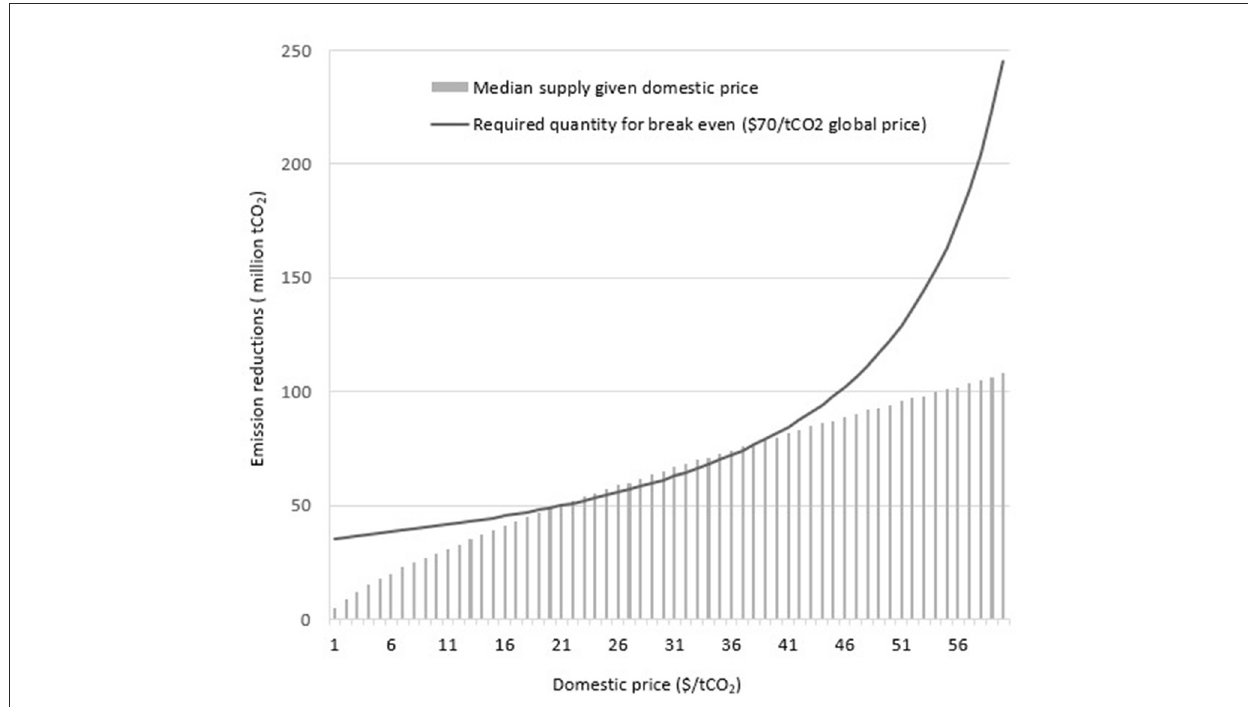
FIGURE5 Median supply of emissions reductions relative to break-even requirement, for global price of $70/tCO 2 . Note: Figure assumes a minimum abatement requirement (tCO 2 ) equal to 35 million tCO 2 such that international payments are only made for abatement exceeding that